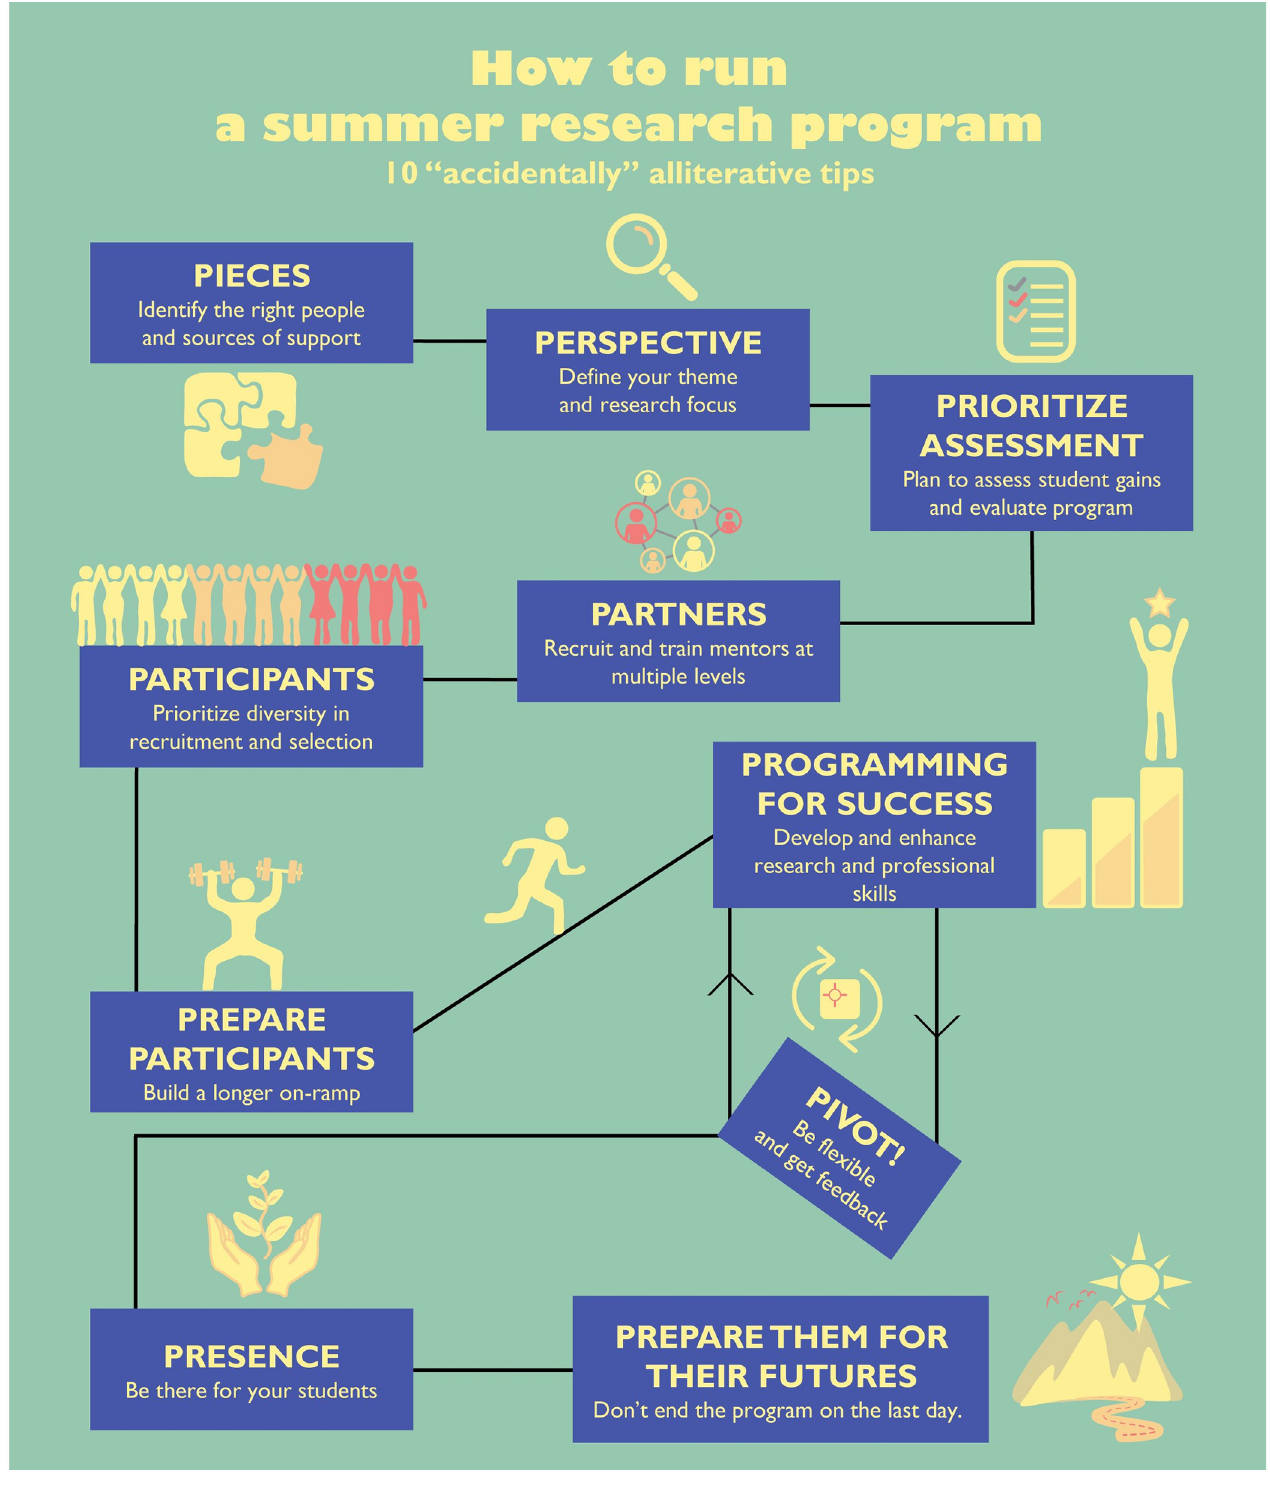
Fig 1. Ten simple rules for running a summer research program in computational biology. A graphical representation of our “accidentally” alliterative rules to planning, offering, running, and improving summer research experiences in computational biology.